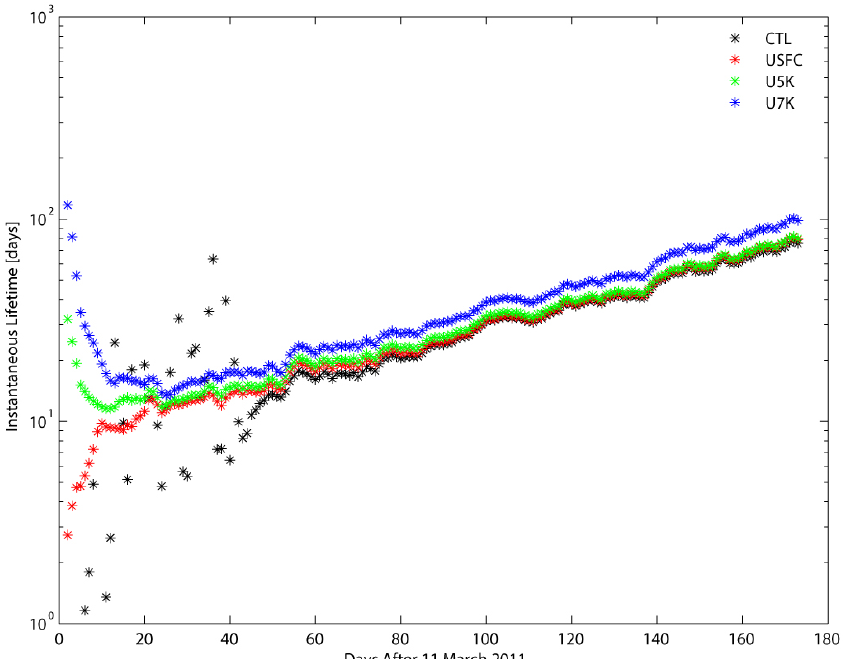
Fig. 3. Instantaneous lifetime ( τ instant ) of the global 137 Cs burden calculated with Eq. (5), for the four GEOS-Chem simulations of this study described in Table